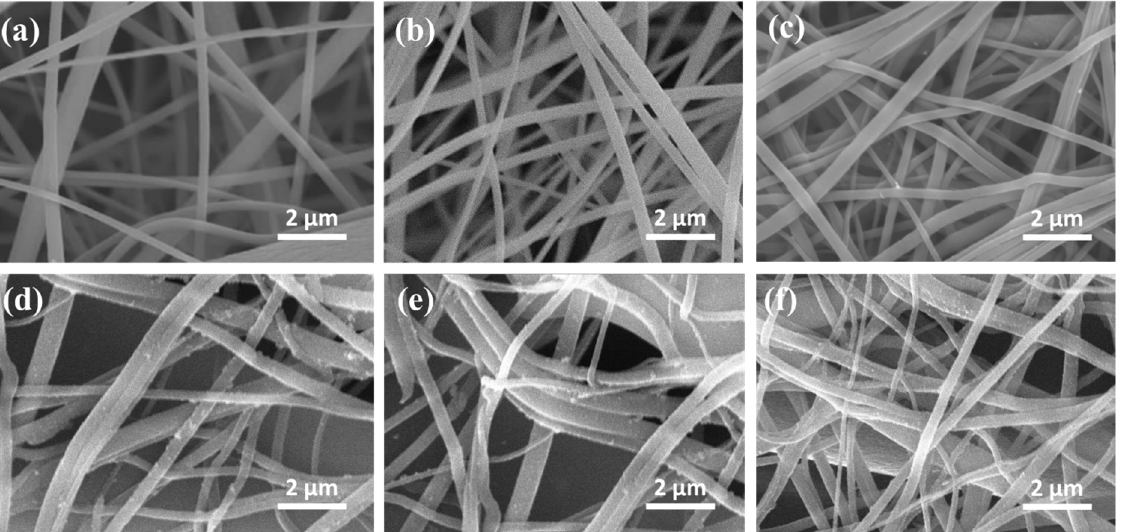
Figure 1. SEM images of ( a ) CA nanofibers, ( b ) CL nanofibers, ( c ) OEO-CL nanofibers, ( d ) Ag-CL nanofibers, ( e ) Ag-OEO5%-CL nanofibers, and ( f ) Ag-OEO10%-CL nanofibers.